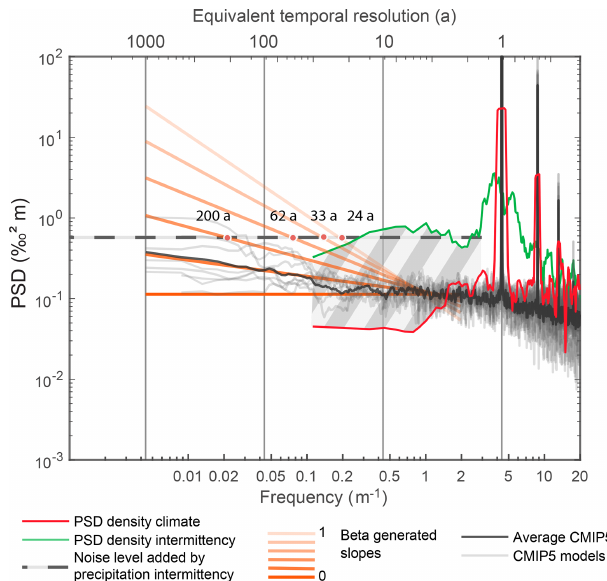
Figure 4. Comparison of the amount of noise generated by precip- itation intermittency and different hypotheses for the climatic sig- nal for the EDML site: PSD generated by the forward model for the climatic signal (red) and the precipitation intermittency (green) virtual cores; area where the noise level added by precipitation in- termittency is calculated (hatched zone) and noise level threshold (hatched line); and several hypotheses for the climatic signal input over 1000 years. The signal retrieval timescales τ b (see Sect. 2.3) are given as the intersection of the noise level and the climatic sig- nal inputs.